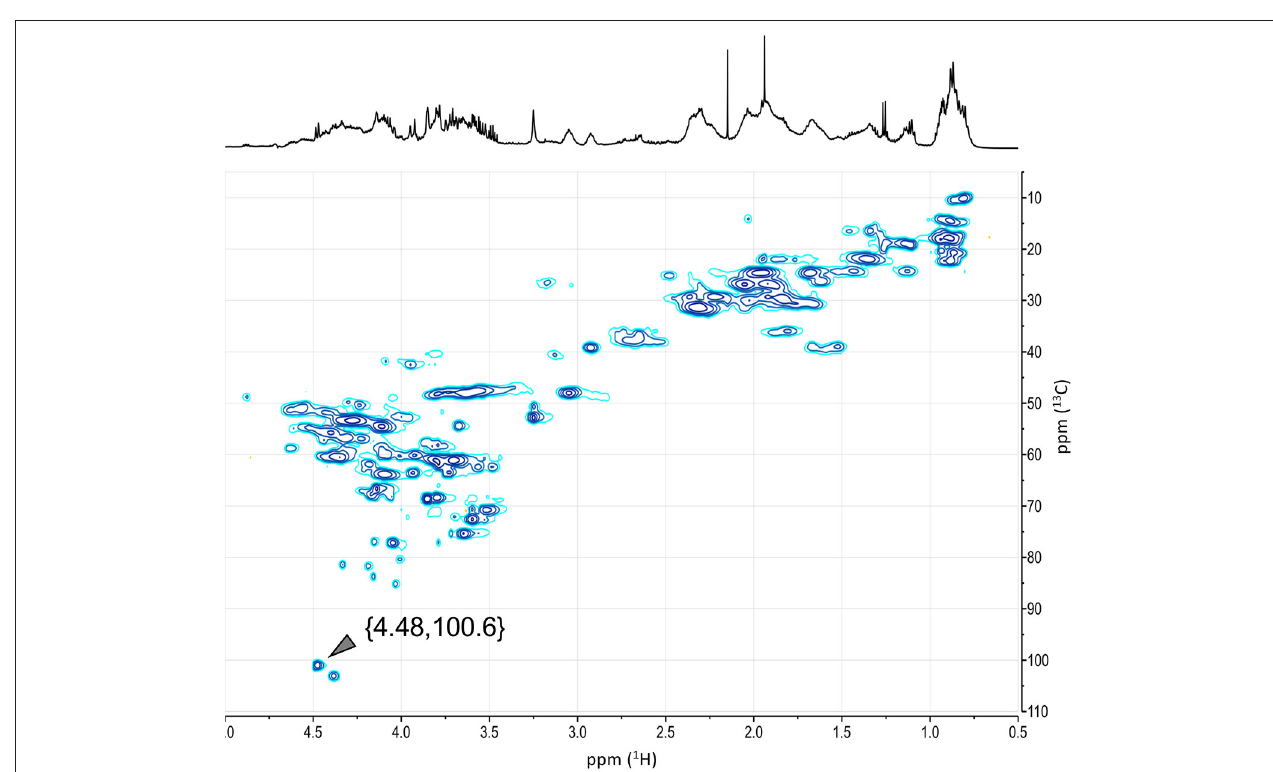
FIGURE 8 | HSQC spectrum of melanoidins from DL prepared at pH i 7.0. The 1 H- 13 C correlation corresponding to imines from Amadori condensation products is annotated. Similar results were observed at higher and lower pH i values (see Supplementary Figure 5 ).